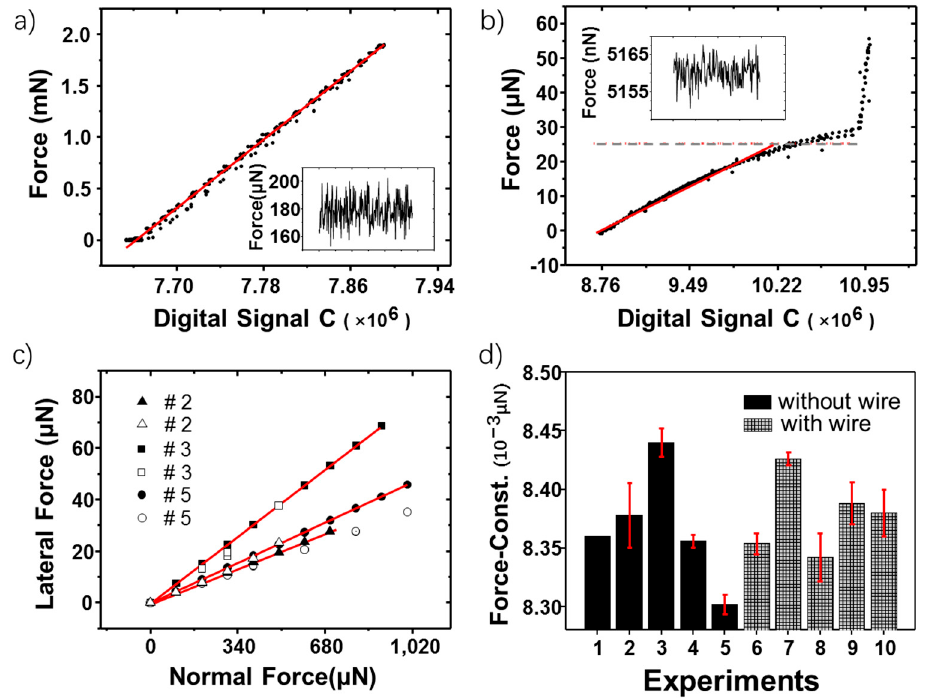
Figure 7. Calibration results. ( a , b ) Relationships between the digital capacitance signals and the reference forces. The inset picture in each picture shows the peak-to-peak noise. The red line is the curve fitting result. ( a ) The normal load sensing part; ( b ) the lateral force sensing part. The grey dotted line represents a force value of 25 µ N, which is the recommended range for a better linearity. ( c ) Geometric coupling calibration. Filled icons are the theoretical results; hollow icons are the experimental results. The red line is the curve fitting. The diagram illustrates the relationship between the applied normal load and the induced lateral signal. ( d ) Assembly error tests. The black columns show the experiments without wires. The grey-grade columns show the experiments with wires. Each height of the column represents an average calibrated force constant ( (cid:52) N / (cid:52) C N ) of each assembly. Error bars are shown to represent the std within each assembly. Table 2. Calibration results of the lateral force sensing part and the available normal load of the corresponding hybrid sensors.